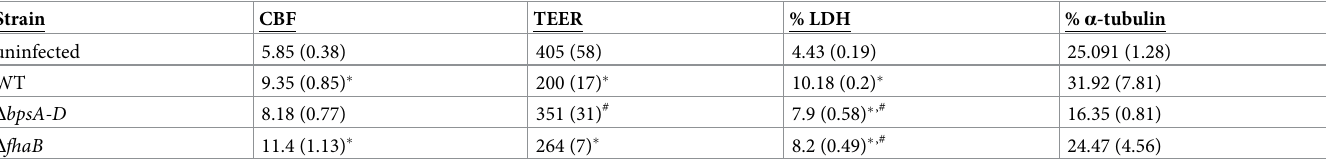
Table 1. HBE culture characteristics upon Bp infection. CBF was quantified from slow-motion capture of 240 frames-per-second. TEER was measured using an epithe- lial voltohmeter, with 300 Ohms � cm 2 as the cut-off for acceptable epithelium integrity. Percent LDH was quantified from basal supernatants. Percent acetylated- α -tubulin was quantified from Fig 4B. Mean values are represented, with standard error of the mean values in parentheses. Data represent at least two independent experiments. Sig- nificance was calculated by using one-way ANOVA. � , p < 0.05 compared to uninfected HBE cells; # , p < 0.05 compared to HBE cells infected with WT. Strain CBF TEER % LDH % α -tubulin